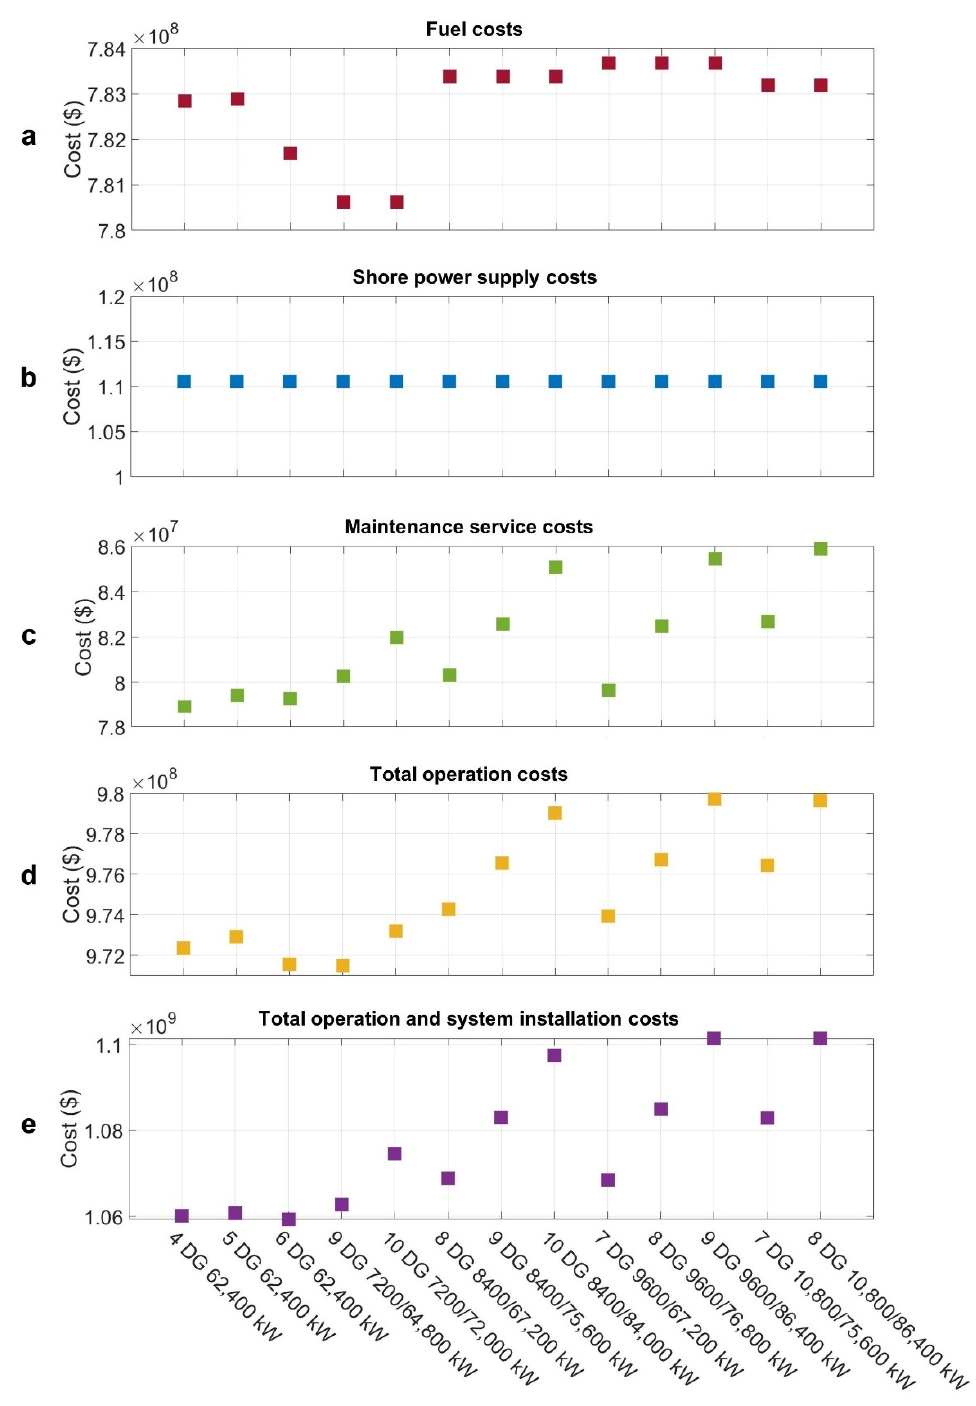
Figure 22. Lifetime cost components of all configuration designs: ( a ) fuel costs ( b ) shore power supply costs ( c ) maintenance service costs ( d ) total operation costs ( e ) total operation and system installation costs.